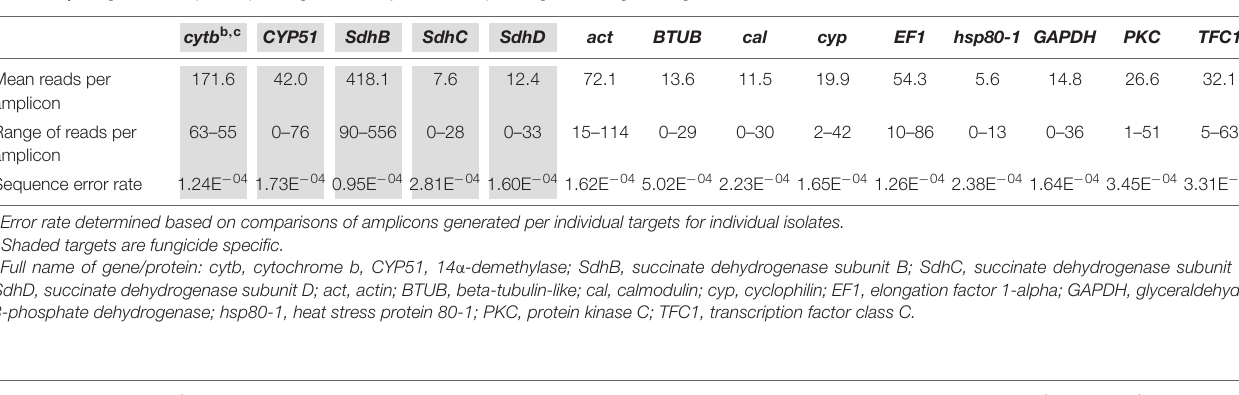
TABLE 3 | Range of reads per amplicon generated by PacBio sequencing for each gene target and associated error rate a